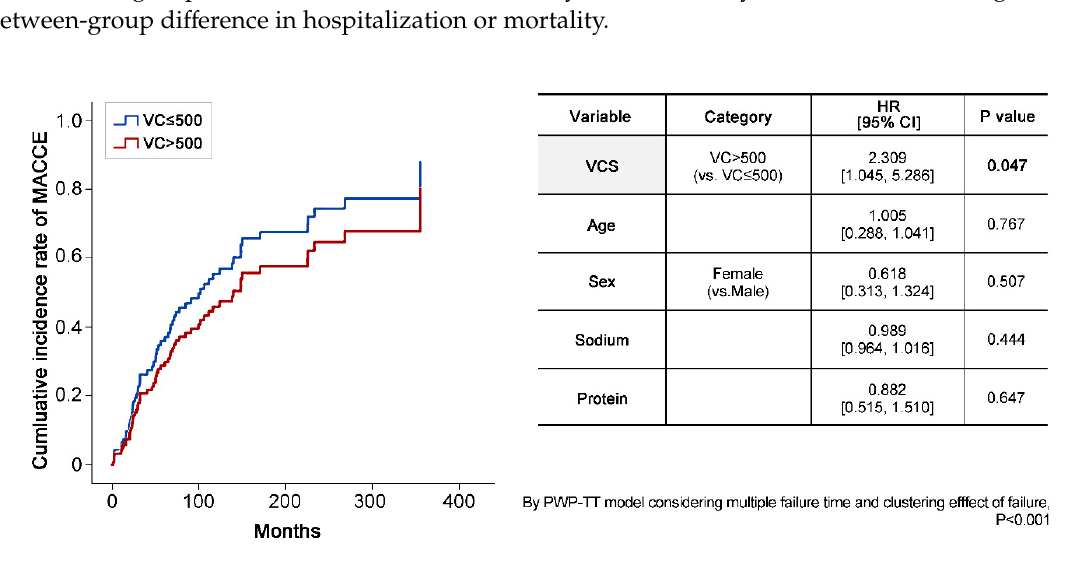
Figure 3. Incidence of interventions in the two VCS groups.